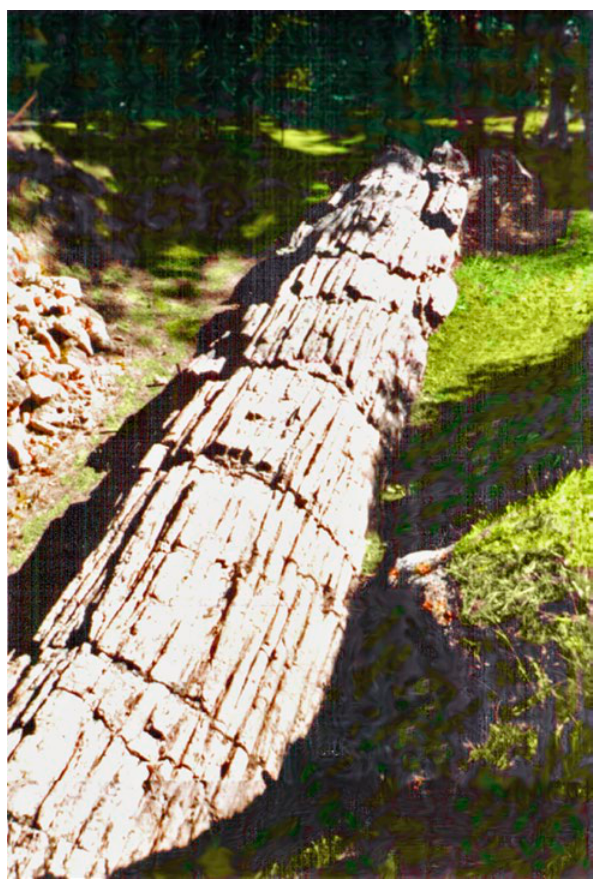
Figure 85. The trunk of a giant redwood tree felled and buried by the ash of a nuée ardente some 3.4 Ma ago is now completely replaced by silica and almost re-exposed by erosion (some excava- tion). Original cellular structures are largely preserved in this ‘petri- fied forest’ some 12 km due south of Mount St. Helena in the Napa valley of